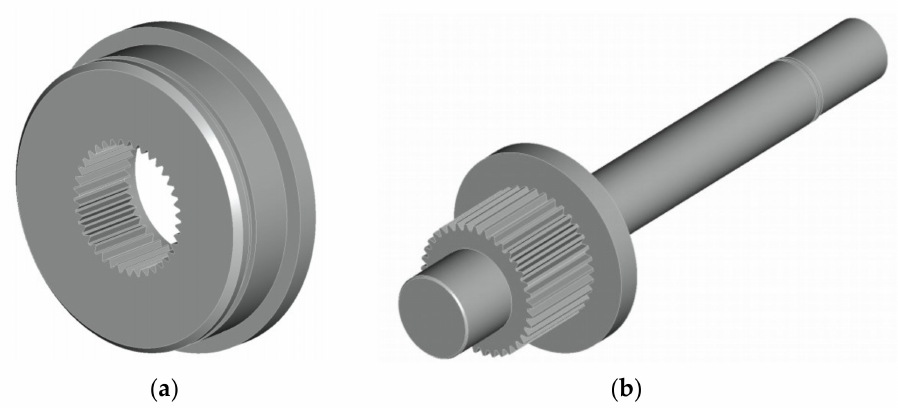
Figure 10. 3D model of the eccentric system: ( a ) the cam; ( b ) the cam body.